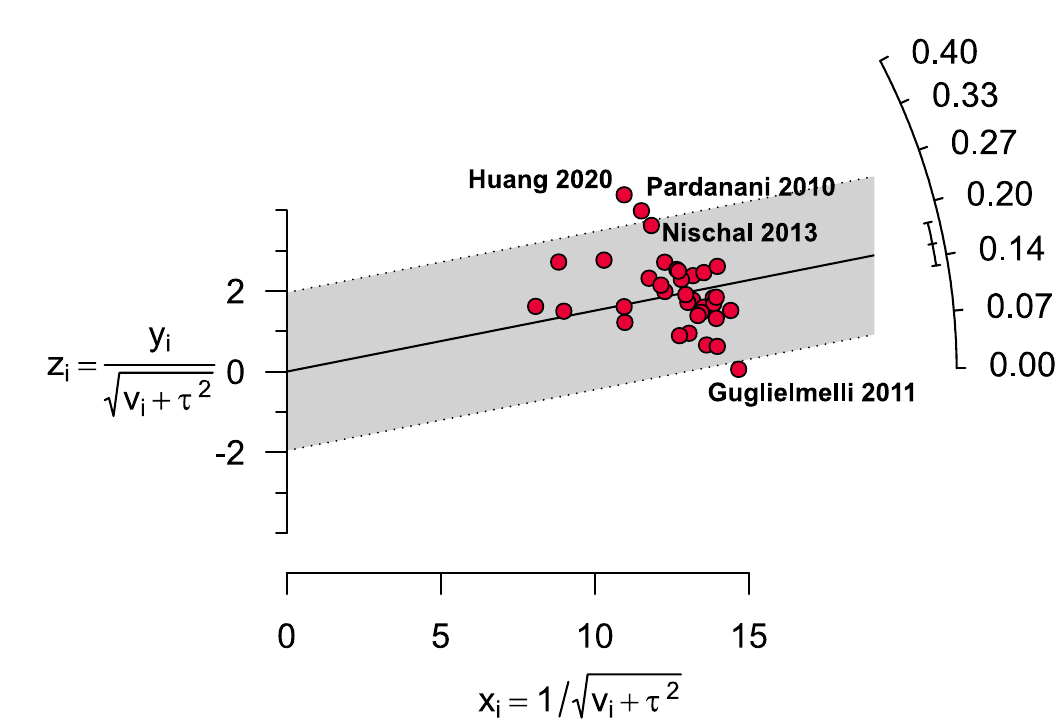
Figure 4. Galbraith plot analysing MPN (overall) identified four outlier studies. Table 3. Sensitivity analyses.